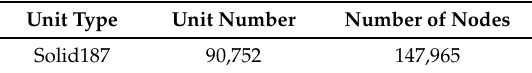
Table 6. Mesh data of the sensor.